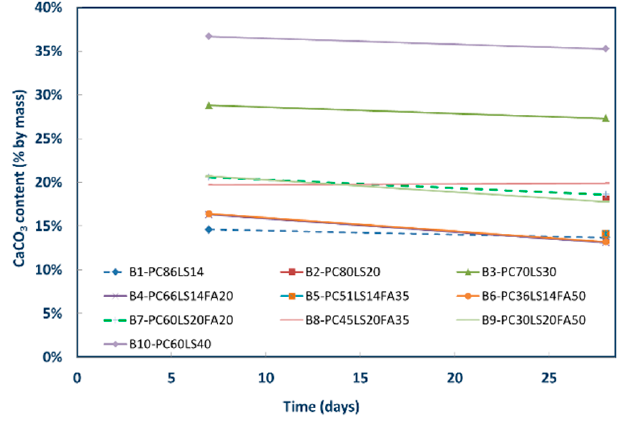
Figure 12. CaCO 3 content of binary and ternary cementitious matrices.